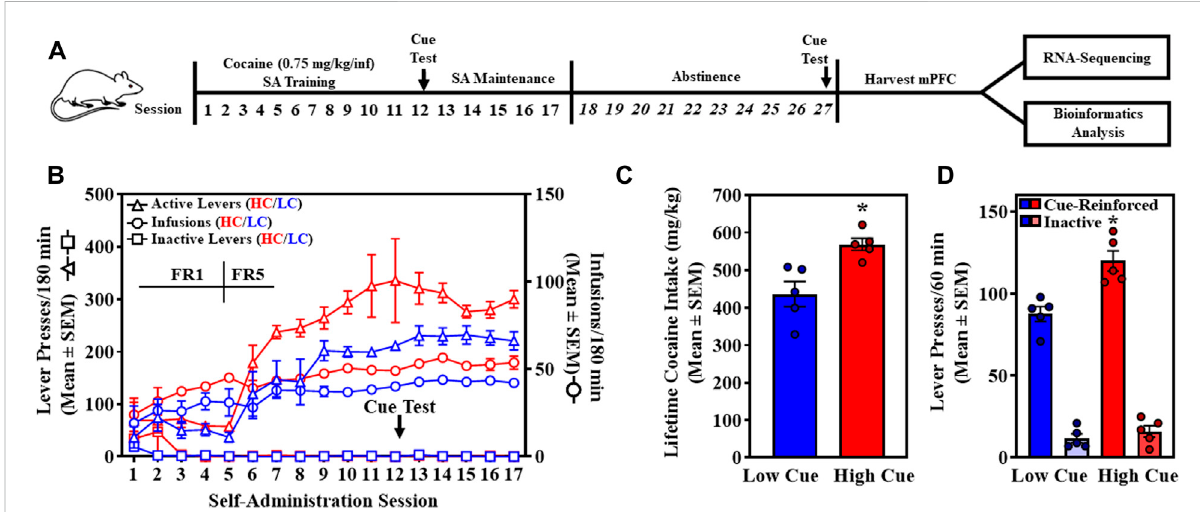
FIGURE 1 Highcue(HC,red)andlowcue(LC,blue)ratsarestrati fi edbylevelsofcue-reinforcedleverpressesintheself-administration(SA)modelpriorto transcriptomic analyses. (A) The experimental timeline is shown. (B) The time course of self-administration sessions is presented as the total presses (mean±SEM)ontheactive(blackcircles;left Y -axis)orinactivelever(whitecircles;left Y -axis),andtotalnumberofcocaineinfusionsobtainedinthe 180-min session (purple circles; right Y -axis). (C) Total lifetime cocaine intake (mg/kg;mean ± SEM) is presented for HC(red) and LC (blue) rats. An unpaired, one-tailed Student ’ s t -test revealed HC rats ( n = 5) self-administered a signi fi cantly higher amount of cocaine (568.31 ± 56.12 mg/kg) relative to LC rats (436.34 ± 33.49 mg/kg) (t 8 = 3.546, p = 0.0076) (unpaired, two-tailed, Student ’ s t -test). (D) Total cue-reinforced lever and inactive lever responding during the fi rst cue test on Day 12 (mean ± SEM) are presented for HC (red) and LC (blue). An unpaired, one-tailed Student ’ s t -test revealed HC rats ( n = 5) displayed signi fi cantly higher lever presses (119.8 ± 6.21) for cocaine-associated cues relative to LC rats ( n = 5; 87.6 ± 4.57)